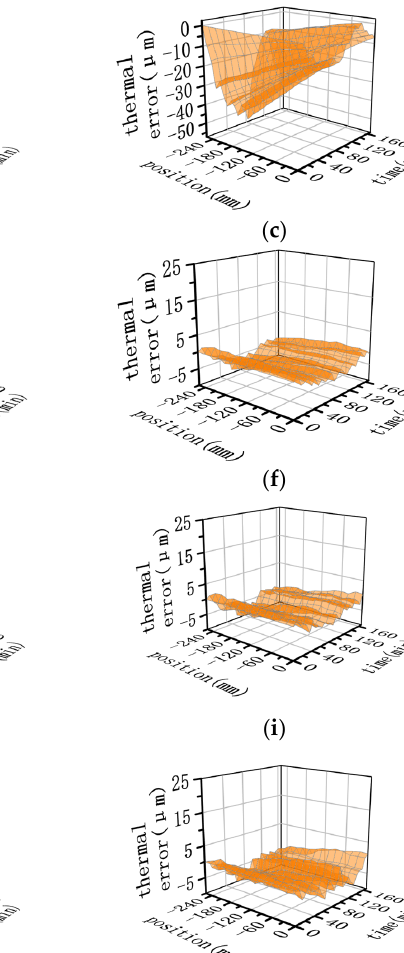
Figure 12. Simulated loading for verification experiment.